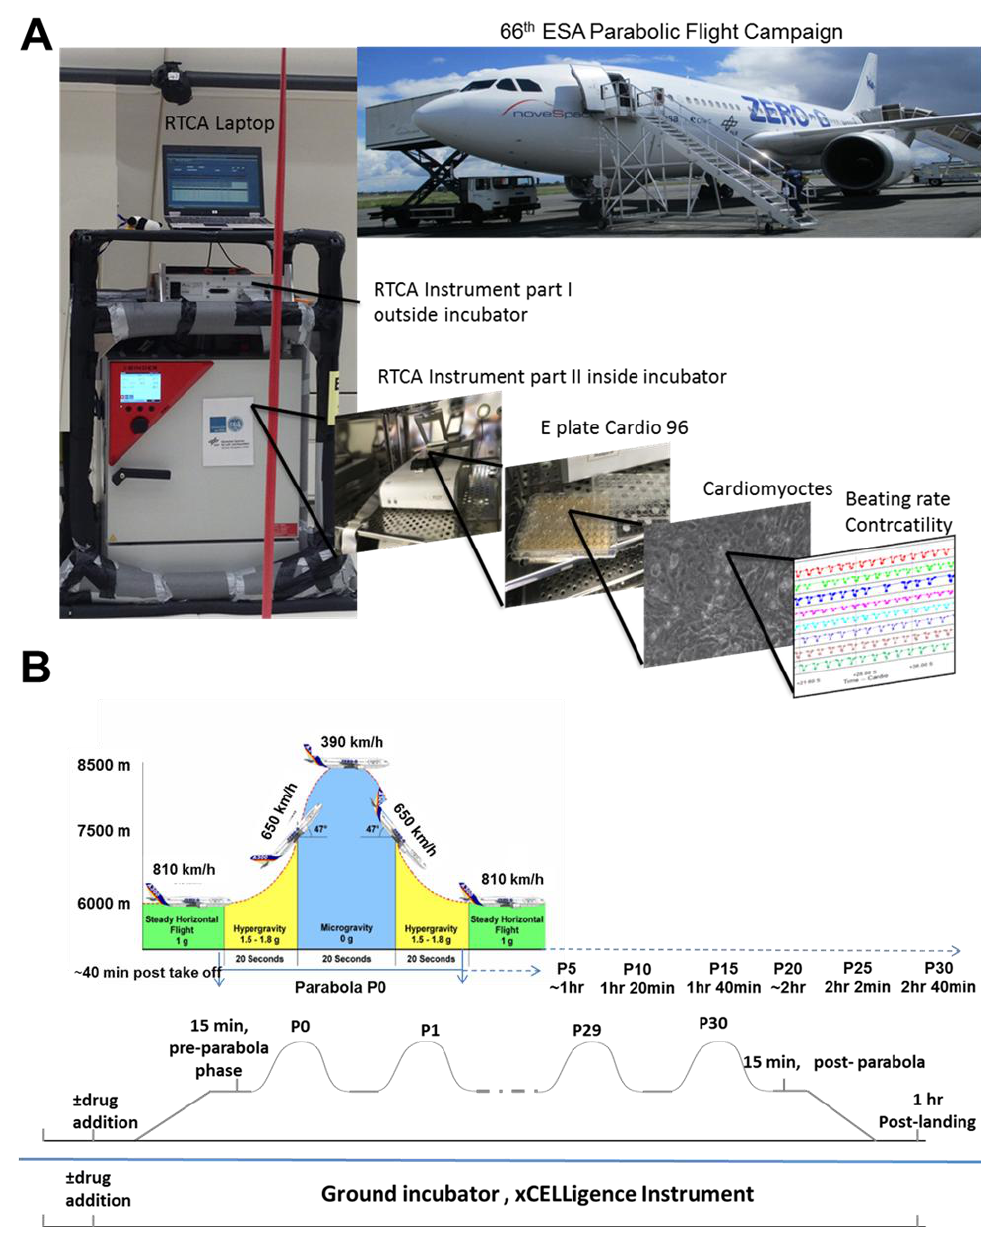
Figure 1. Experimental scheme for parabolic flight experiments carried out during the 66th Parabolic Flight Campaign of the European Space Agency. ( A ) Schematic of the instruments used during parabolic flight experiments. ( B ) Schematic showing flight maneuvers and time points before parabola P0 and after P30.